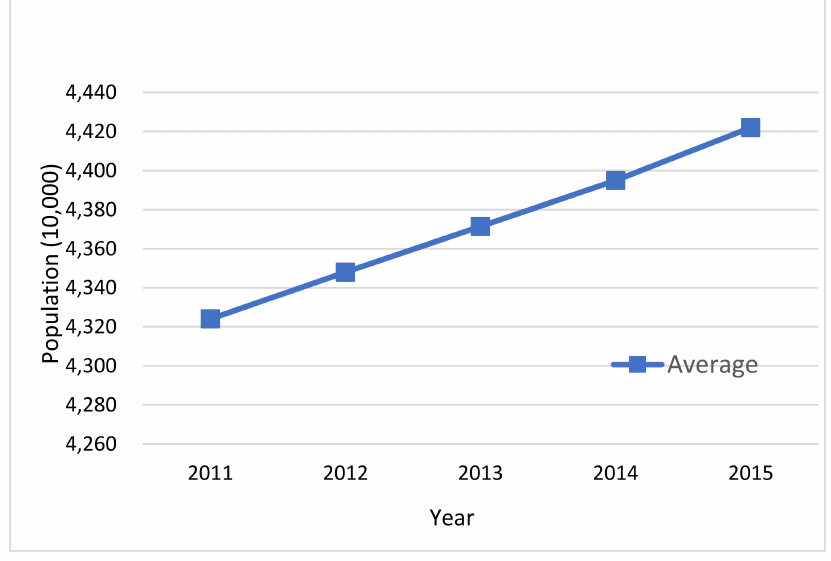
Figure 2. Average population over 2011–2015 in